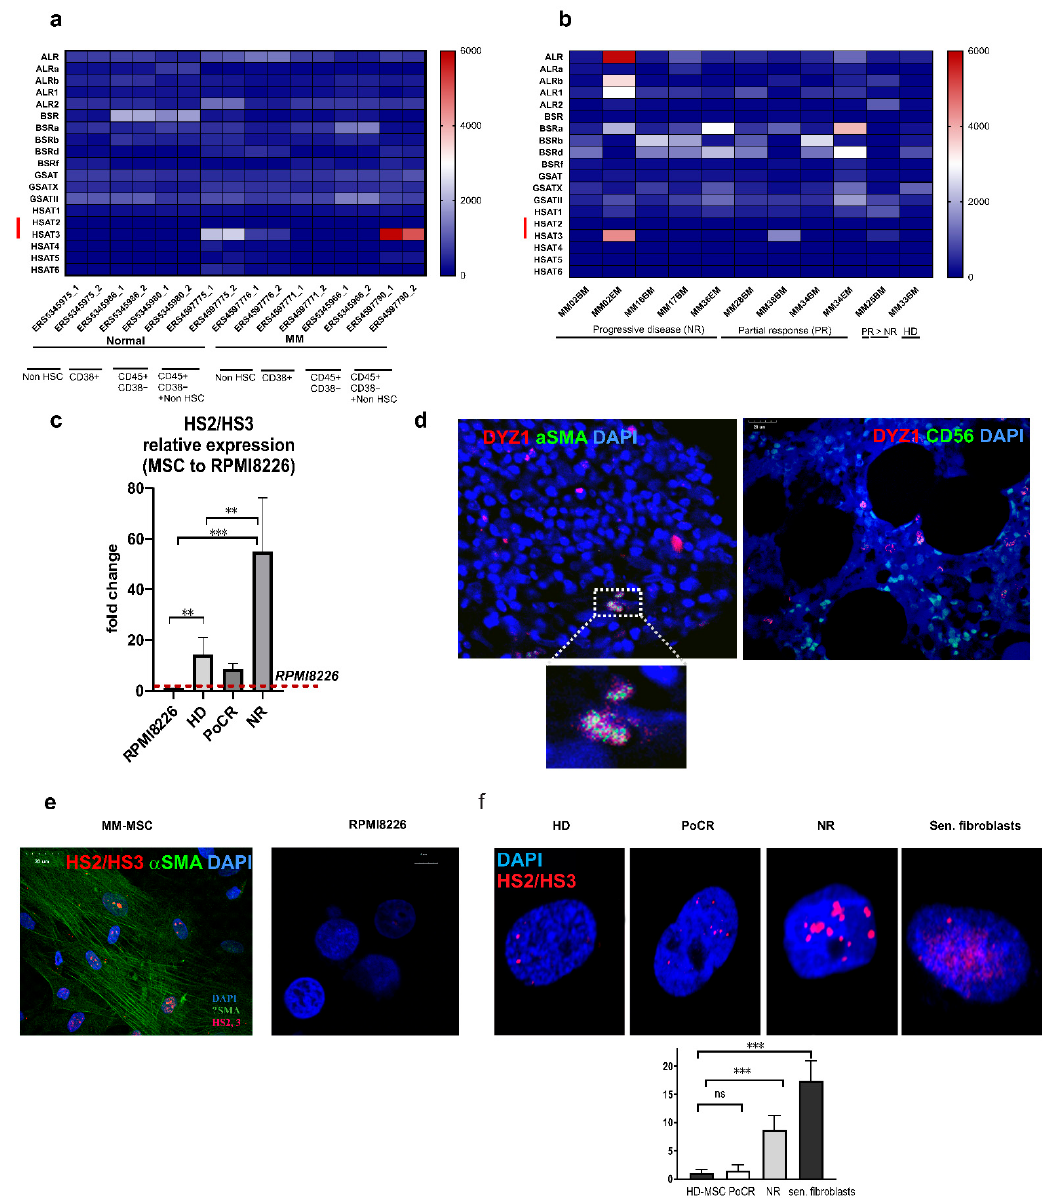
Figure 5. HS2/HS3 TR DNA transcription in MM-MSC. ( a ) A heatmap of TR transcripts TPM (transcripts per million) in single-cell transcriptomes of different BM populations; ( b ) a heatmap of TR transcripts TPM in single-cell MM transcriptomes of patients with different disease; TR DNA families abbreviations: ALR = α -satellite repeats, BSR = β -satellite repeats, GSR = γ -satellite repeats, HSR = human satellite repeats; red lines mark HS2/HS3 families. ( c ) qPCR of cDNA samples from NR-MSC, PoCR MSC, HD-MSC, and RPMI8226; fold change is plotted on the Y-axis, the red dashed line marks the value of transcription in RPMI8226 set as 1; GAPDH was used as a reference gene. ( d ) Pericentromeric HS2/HS3 transcripts revealed in BM trephines of MM patients by DNA–RNA FISH (red). Samples were co-stained (green) either with an anti α SMA (to reveal α SMA+ MSC) or anti- CD56 antibody (to reveal cancer cells). ( e ) After trephines examination, HS2/HS3 transcripts (red) were probed in MSC and RPMI8226 grown in vitro by DNA–RNA FISH; MSC were co-stained with an antibody against α SMA (green). ( f ) HS2/HS3 transcription in MM-MSC of patients with different responses to treatment. The results of quantification are given below the images. Nuclei in ( d – f ) were counterstained with DAPI. The scale bar is indicated in the images. Abbreviations: DAPI = 4’,6- diamidino-2-phenylindole; FISH = fluorescence in situ hybridization; HS2/HS3 = human satellite 2,3; MSC = mesenchymal stromal cells; PoCR = partial or complete response; α SMA = α -smooth muscle actin. ** p < 0.01, *** p < 0.001, ns = non-significant ( p >